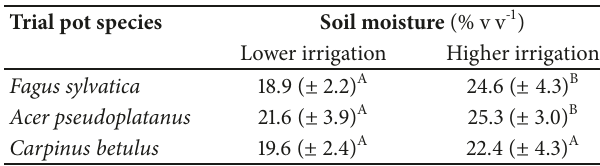
Table3: Comparisonsofsoilmoistureconditions(volumetricwater content) in the trial pots between lower and higher irrigation treatments for all three tree species (n = 10, per species). Presented are mean values with standard deviation. Uppercase letters